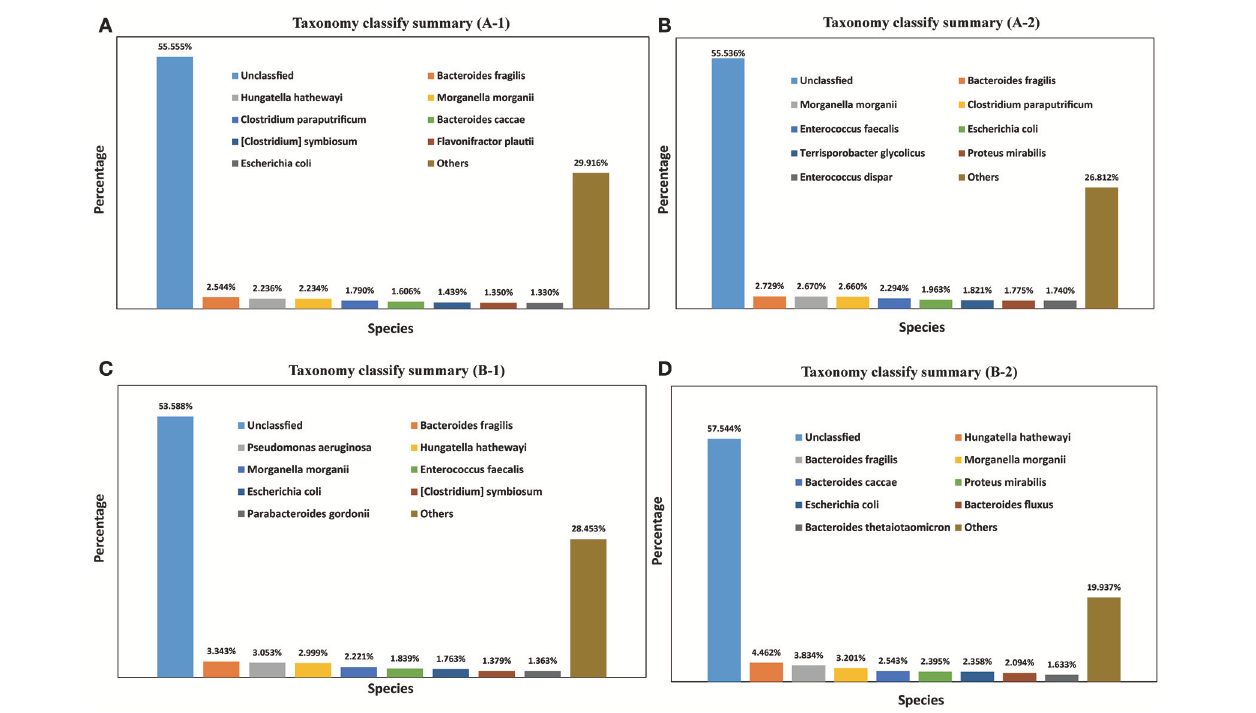
FIGURE 4 | Taxonomy classification summary. The top 8 annotations in four Manis javanica at species level are shown in different colors. (A) Taxonomy classify summary (A-1), (B) taxonomy classify summary (A-2), (C) taxonomy classify summary (B-1), and (D) taxonomy classify summary (B-2).